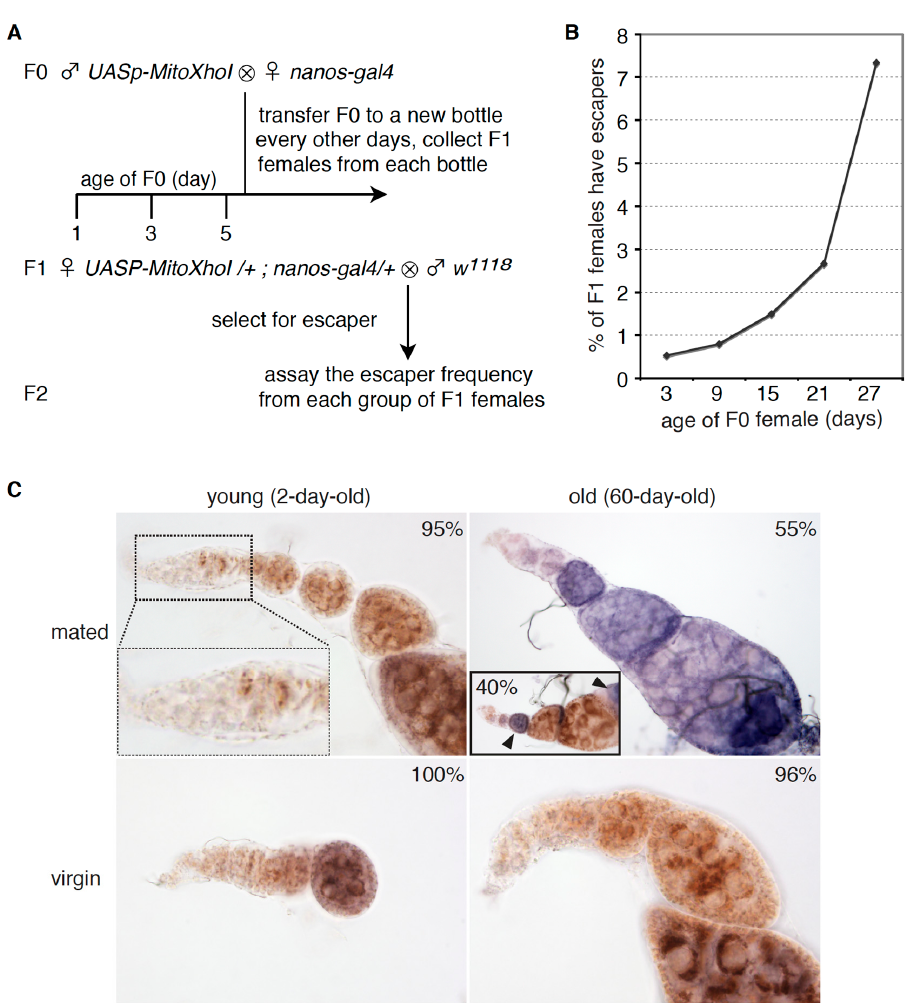
Figure 4. Aged GSCs have increased mtDNA mutation loads and defective electron transport chain complexes. ( A ) Cross scheme to assay the influence of maternal age (F0) on mtDNA mutation frequency in progeny (F1), as an indication of mtDNA mutation loads in F0 GSCs. ( B ) The different groups of F1 females expressing mitoXhoI in germ cells ( UASp-MitoXhoI/+; nanos-gal4/+, n > 100) were produced by the same group of F0 females ( nanos-gal4 ) at different ages. The frequency of fertile F1 females, as an indication of mtDNA mutation frequency in F0 GSCs is plotted against age of F0 females. The positive correlation between the number of fertile F1 females and the age of F0 females suggests that there were more mtDNA mutations in older GSCs in F0 females. ( C ) Ovaries of young (2-day-old) or old (60-day-old) females that were either mated with males or maintained as virgins were stained for dual succinate dehydrogenase and cytochrome C oxidase (COX) activity. The representative images and their percentage ( n = 20) for each group are shown. Nearly 100% of ovaries of young mated females, young virgins and old virgins displayed normal COX activity (brown color). Note that the anterior part of the germarium (boxed and enlarged view), the location of stem cells and early stage cysts are nearly colorless, showing that mitochondria are mostly inactive in this developmental stage. In addition, 55% of ovaries from old mated females were completely lacking in COX activity (blue color). Forty percent of ovaries from old mated flies (inserted panel) showed a mosaic pattern of normal and deficient COX activity (arrowheads), suggesting that COX is normal in one germ line stem cell, but disrupted in another one in the same